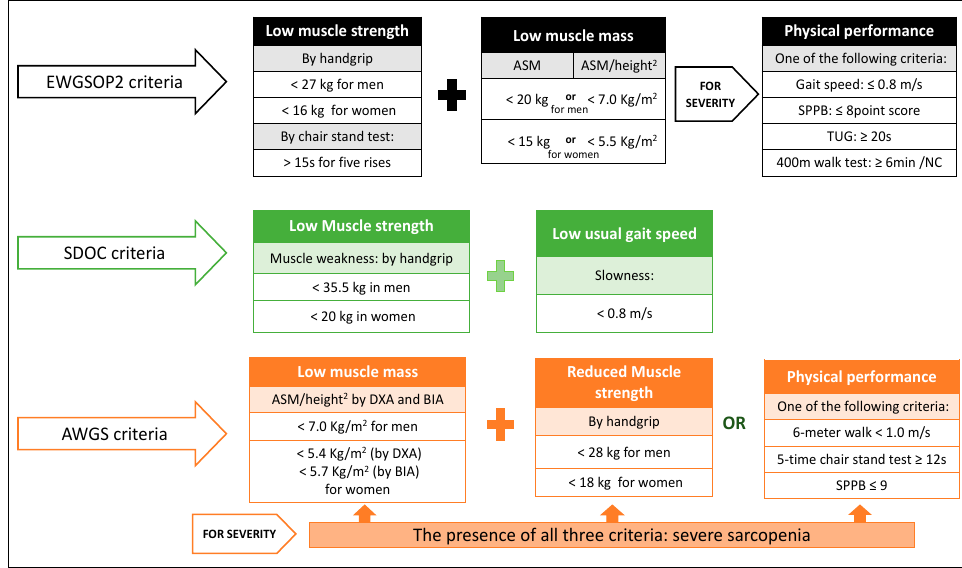
Figure 1. Update of the sarcopenia diagnostic criteria. Abbreviations: EWGSOP2: European Working Group on Sarcopenia in Older People 2; AWGS: Asian Working Group for Sarcopenia; SDOC: Sarcopenia Definition and Outcomes Consortium; ASM: Appendicular Skeletal Muscle Mass; SPPB: Short Physical Performance Battery; TUG: Timed-Up and Go test; NC: Non-completion. DXA: Dual-energy X-ray Absorptiometry. BIA: Bioelectrical Impedance Analysis [20,23,25].